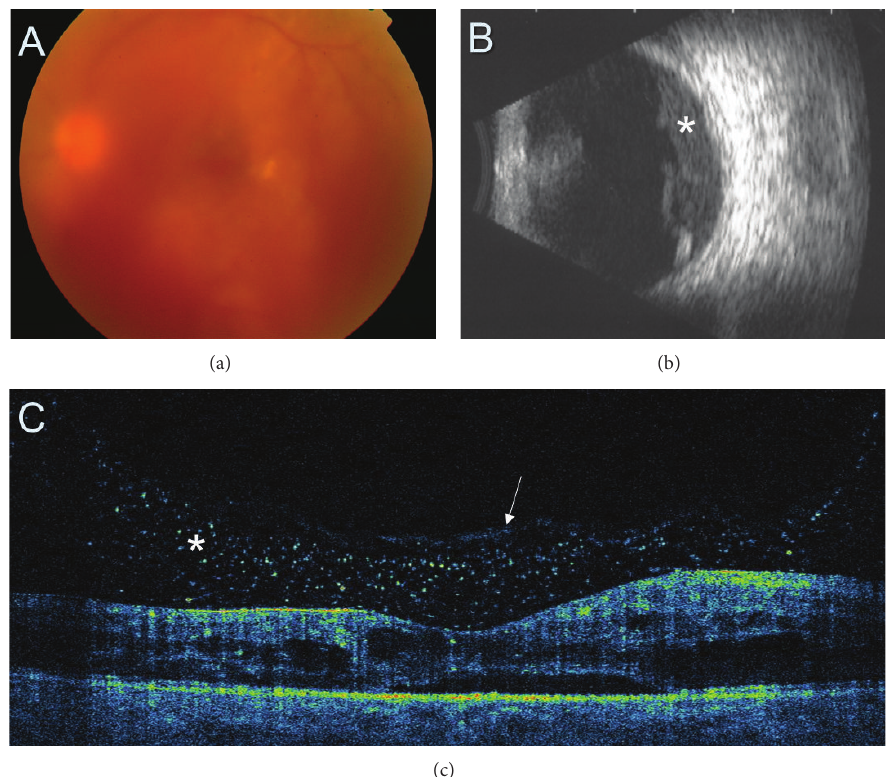
Figure 11: (a) Colour fundus photography demonstrating moderate vitreous haemorrhage obscuring the view of the macula and the posterior pole. (b) Ultrasonography presents preretinal vitreous haemorrhage (asterisk). (c) SDOCT tomogram. Although fundus assessment in ophthalmoscopy is impossible, SDOCT clearly shows cystic DME with preretinal blood accumulation (asterisk). Posterior vitreous face is marked with a white